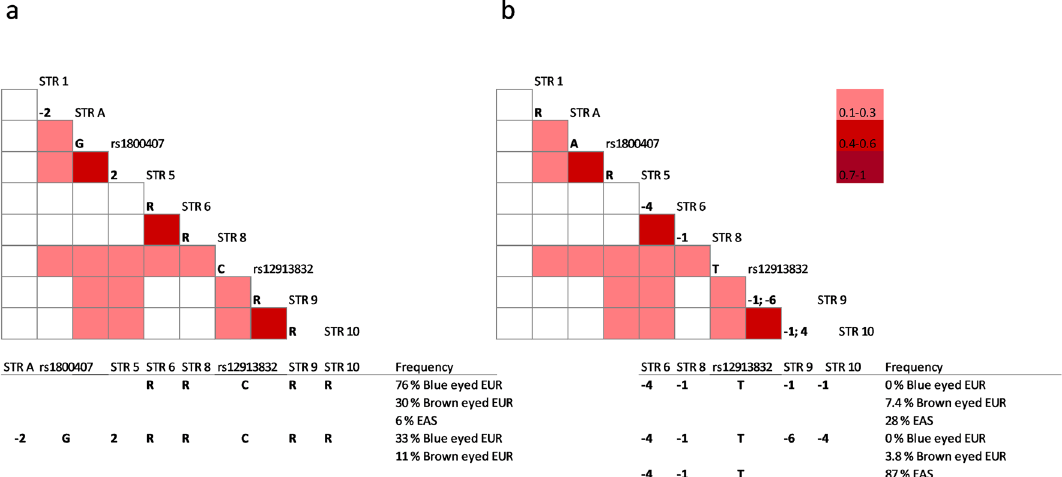
Figure 5. European haplotype block structure and pattern of LD of the OCA2-HERC2 region including selected polymorphic STR markers and SNPs rs1800407 and rs12913832. LD r 2 values are showed by the standard color scheme indicated. Only values higher or equal to 0.1 associated to a minimum of five allele counts are reported. ( a ) indicates allelic associations around the allele C of rs12913832 (n = 1105), ( b ) indicates allelic associations around the allele T of rs12913832 (n = 641). Below the plots are reported selected haplotypes and relative frequency values in specific